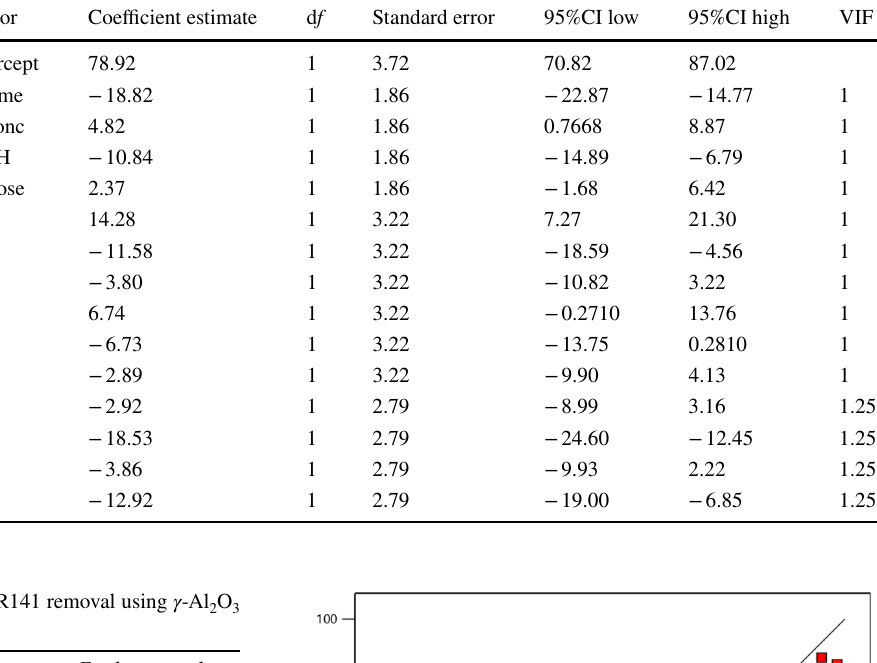
Table 4 Coefficients estimation for quadratic model of RR-141 removal